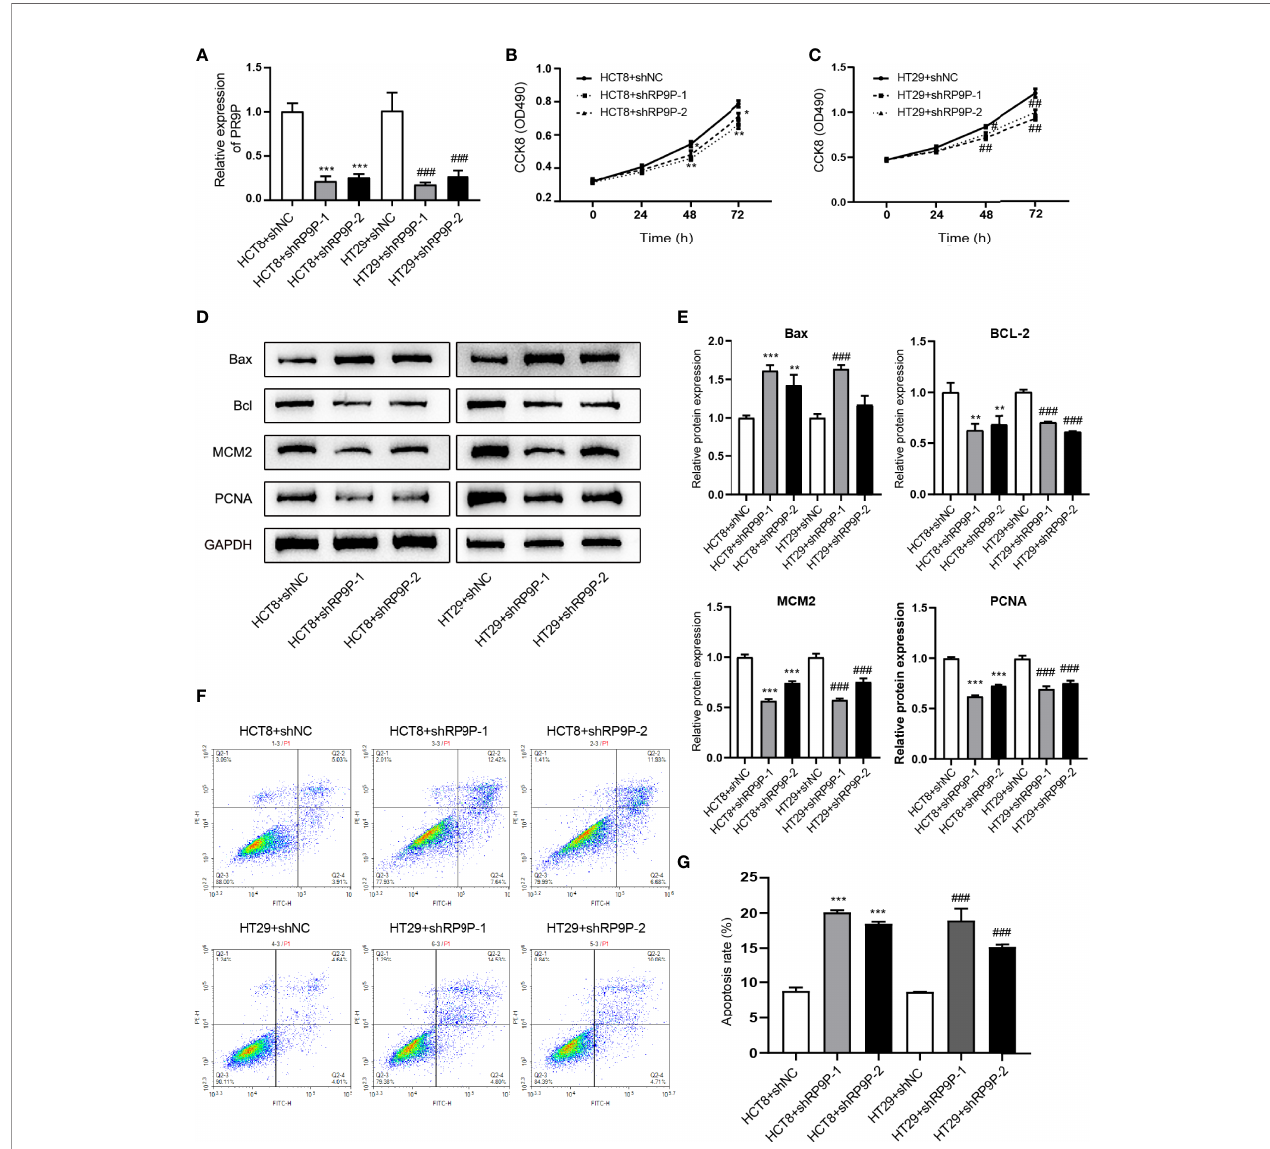
FIGURE 2 | Effect of downregulated RP9P on colorectal cancer cell viability. (A) Expression of RP9P in HCT8 and HT29 cells with RP9P stably silenced was con fi rmed using real-time PCR. (B, C) HCT8 (B) and HT29 (C) cell proliferative ability with RP9P stably silenced was analyzed using the CCK-8 assay. (D, E) The levels of BAX, BCL2, MCM2, PCNA, and GAPDH were measured through western blotting (D) . Data are presented as means ± standard deviation (E – G) Percentages of apoptotic HCT8 and HT29 cells (F) were measured using fl ow cytometry. The histograms show the average numbers of apoptotic cells (G) (* p < 0.05, ** p < 0.01, *** p < 0.001 vs. HCT8 + shNC; # p < 0.05, ## p < 0.01, ### p < 0.001 vs. HT29 +